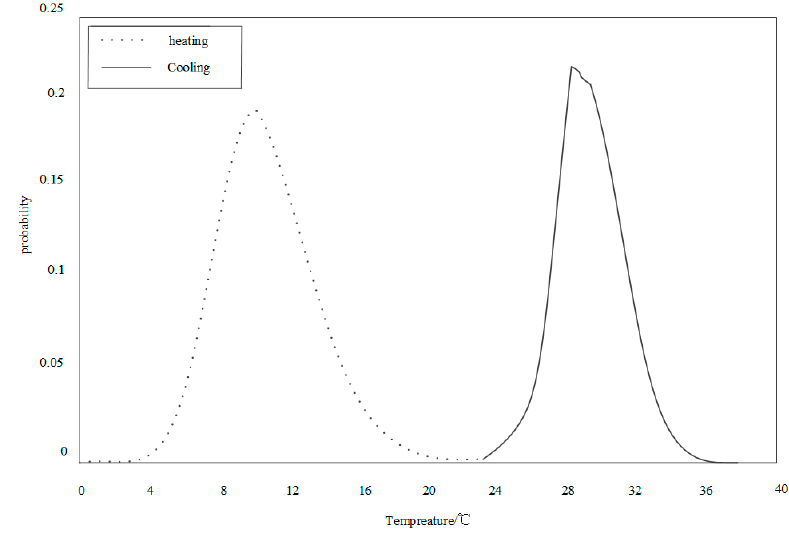
Figure 1. Probability distribution of AC system start.